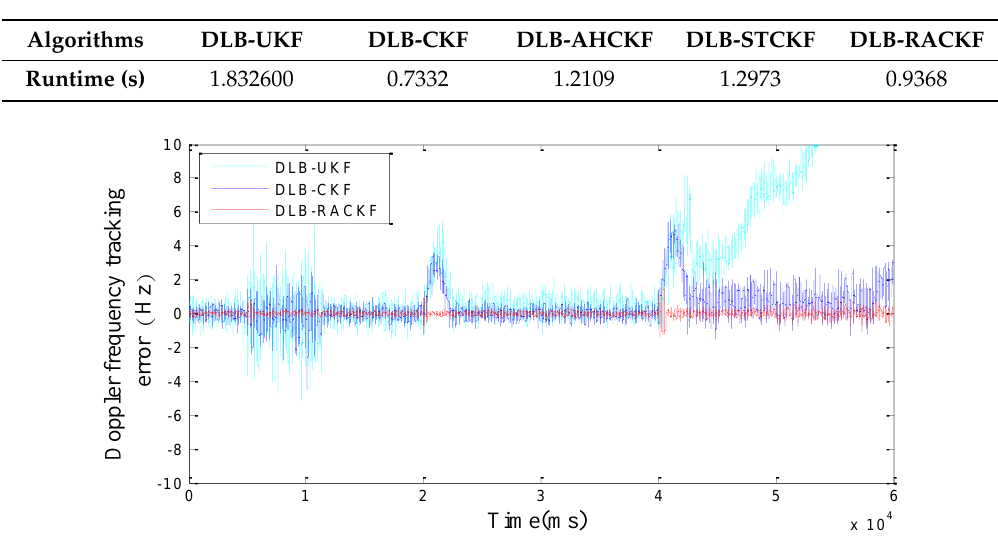
Figure 3. Comparison of the Doppler frequency tracking error among DLB-UKF, DLB-CKF, and DLB-RACKF.